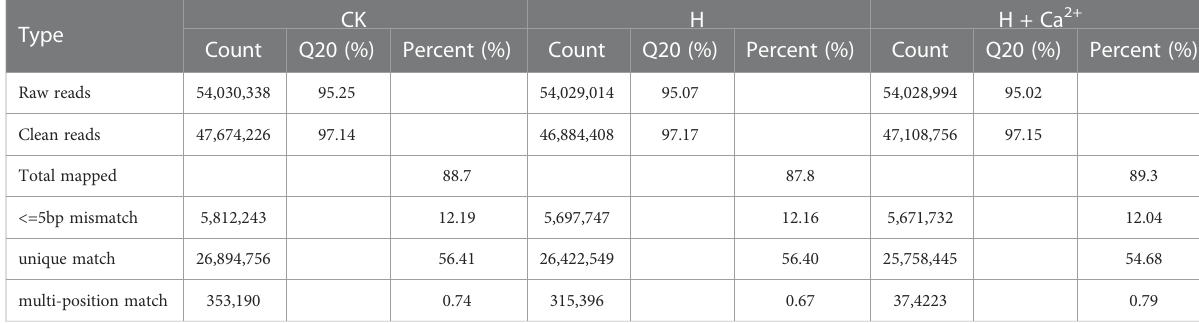
TABLE 2 Summary of DGE sequencing and mapped